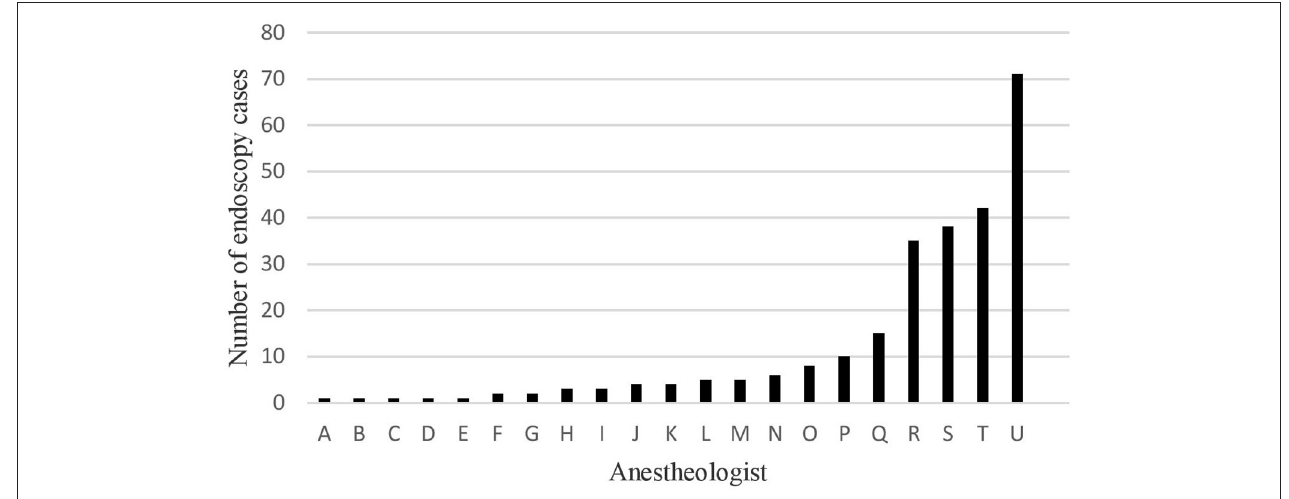
FIGURE 1 | Number of endoscopy cases performed by each anestheologist ( N = 21).